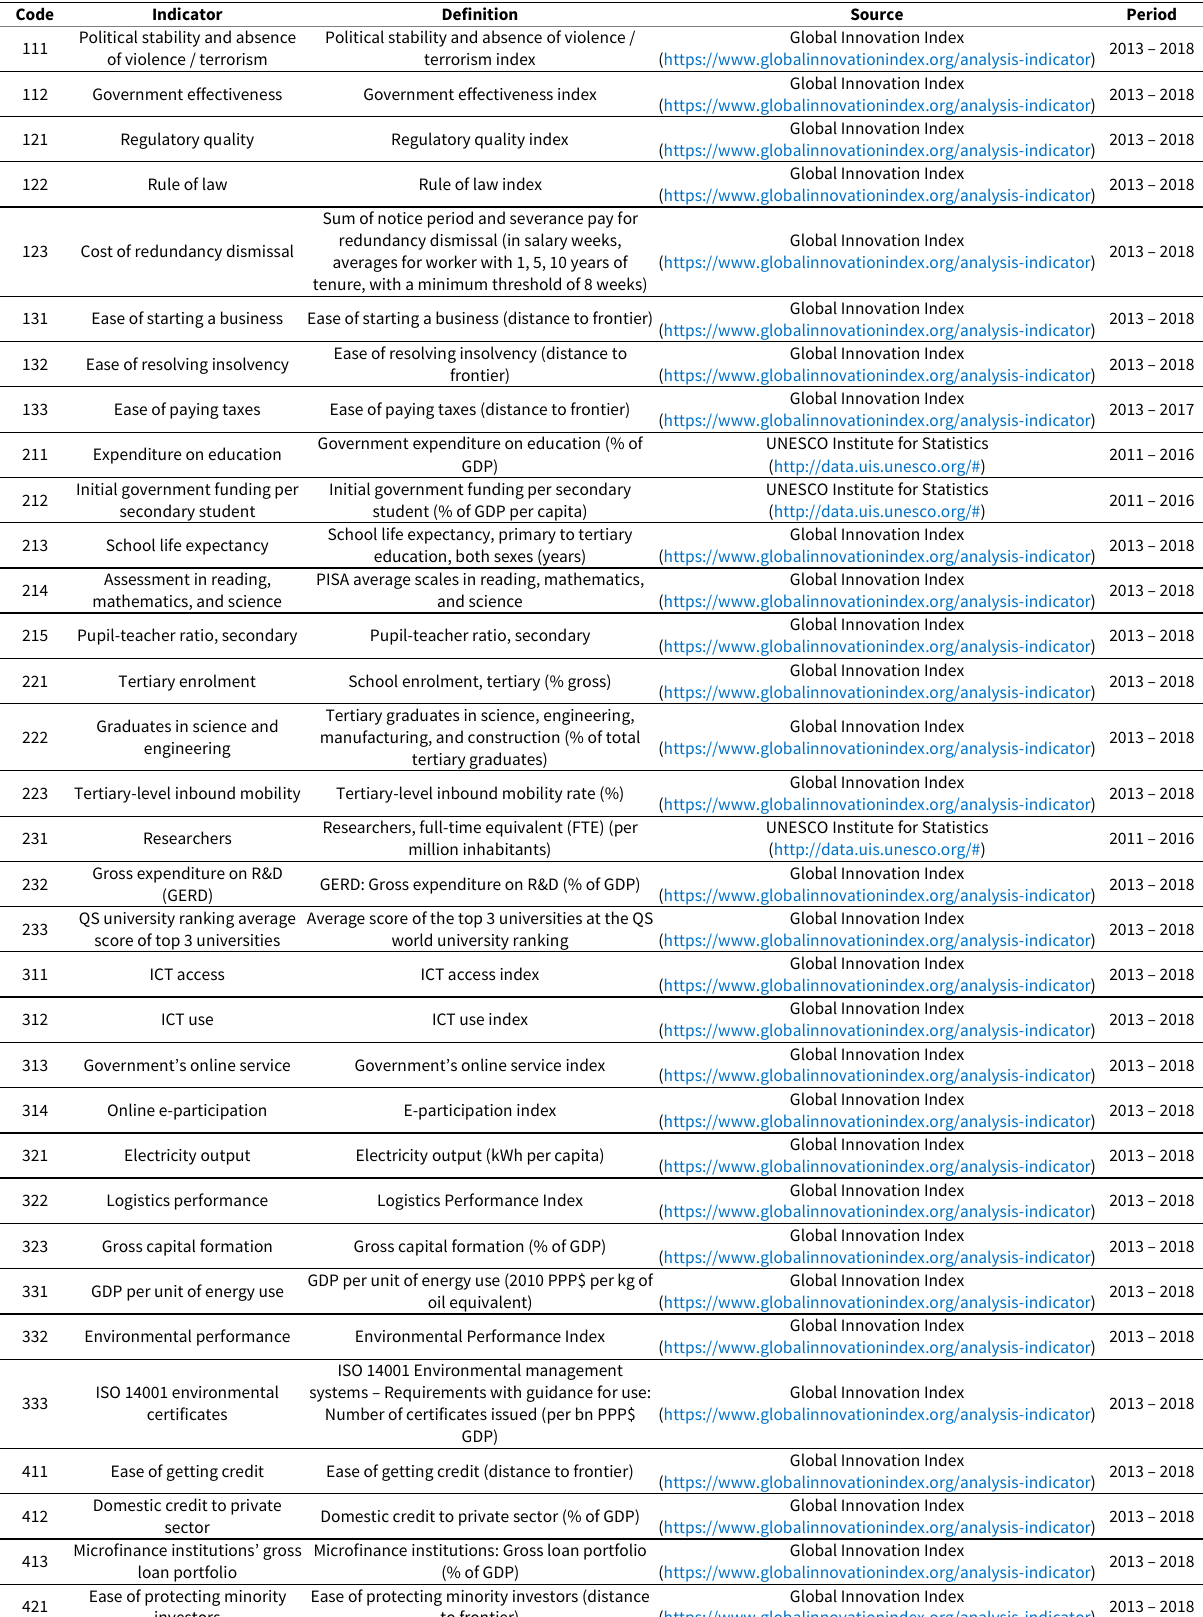
Table A1. Variables used, codes, definitions, sources and time-series